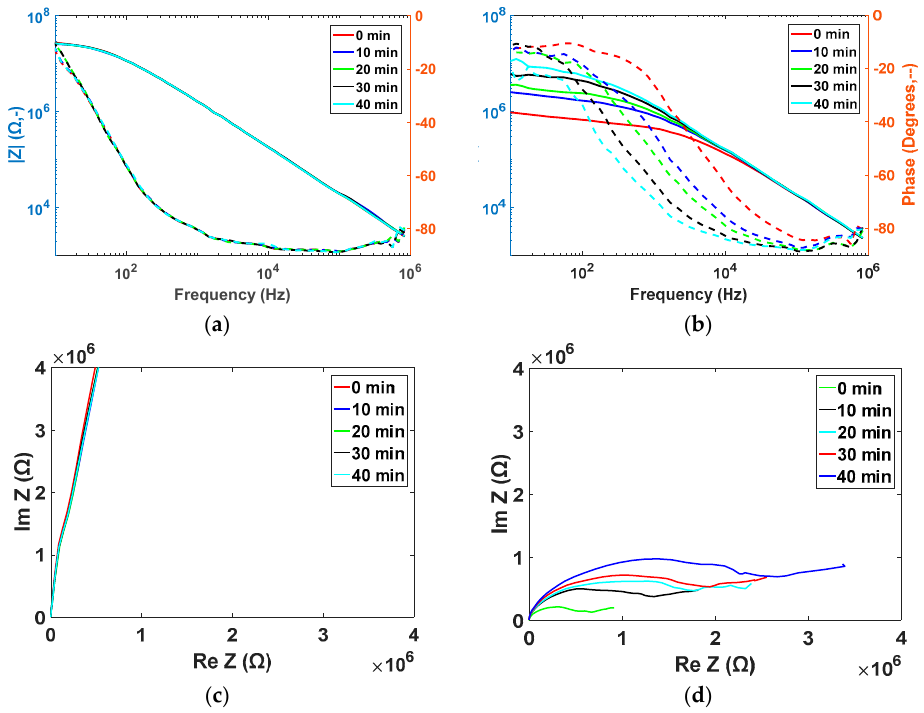
Figure 4. Representative bode and Nyquist plots for progressive exposure of ( a , c ) uncoated and ( b , d ) gelatin-coated sensors to 1 mg/mL trypsin in buffer. Solid (-) and dotted (--) lines indicate |Z| and the phase, respectively.